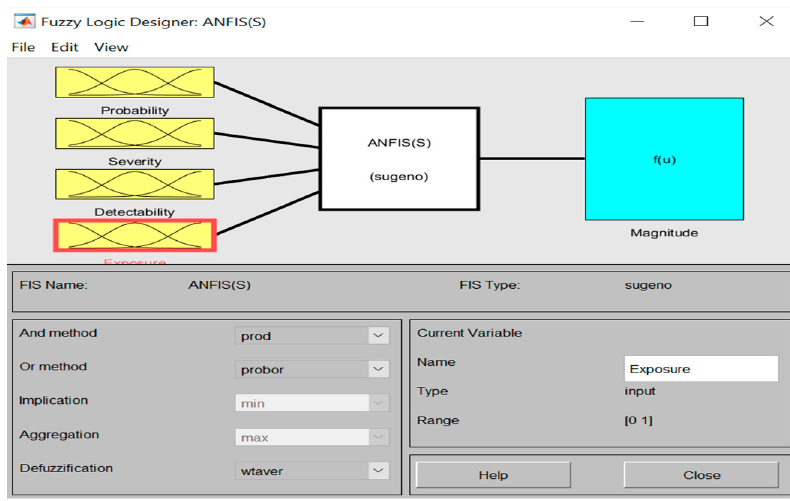
Figure 5. Structure of used ANFIS model. Int. J. Environ. Res. Public Health 2020 , 17 , x